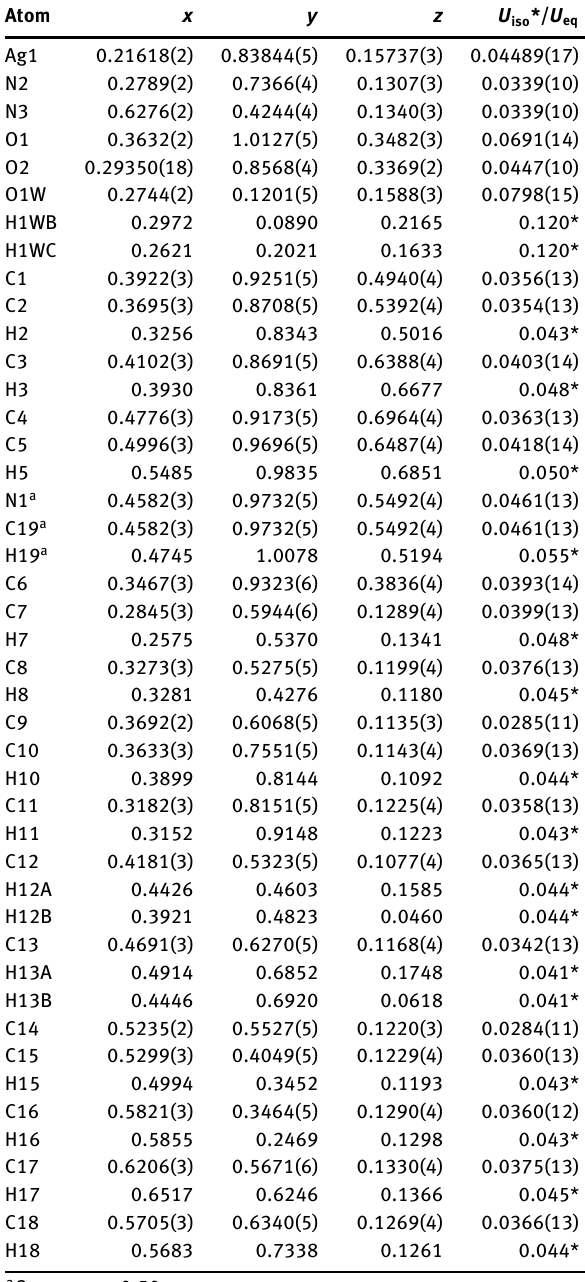
Table 2: Fractional atomic coordinates and isotropic or equivalent isotropic displacement parameters (Å 2